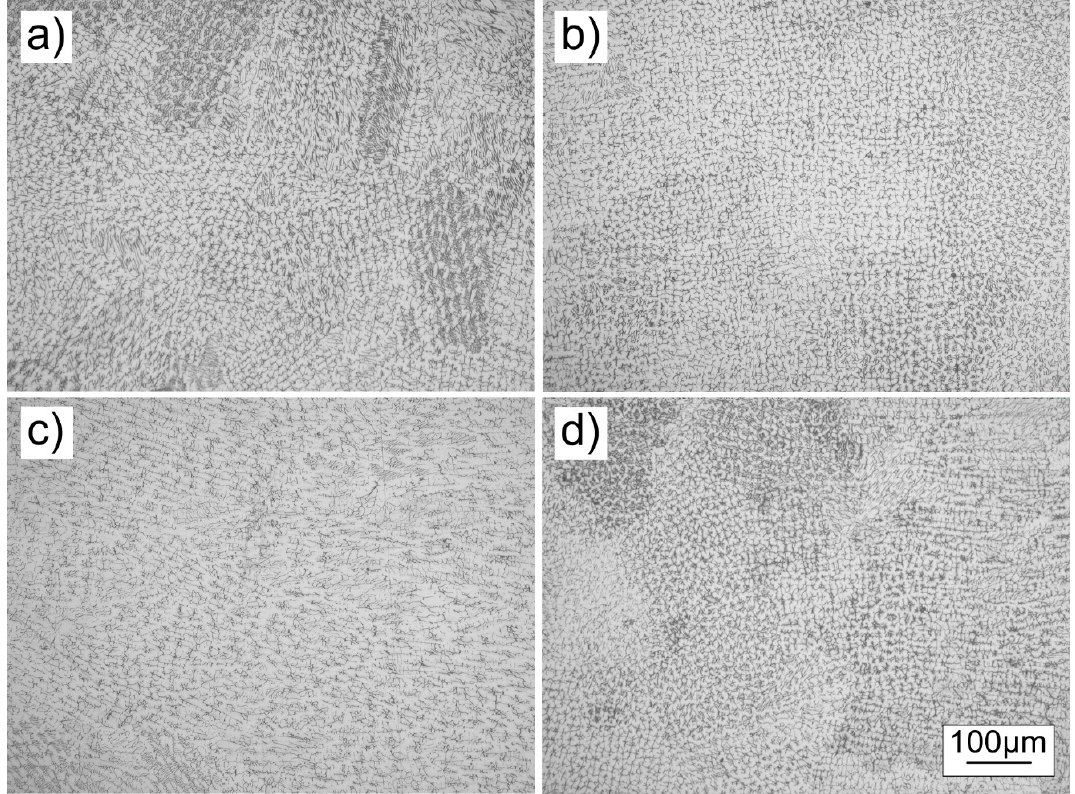
Figure 3. Microstructures of weld metals of specimens: ( a ) 0; ( b ) 4Si1Ti; ( c ) 3Si2Ti; ( d ) 5Ti. Metals 2019 , 9 , x FOR PEER REVIEW